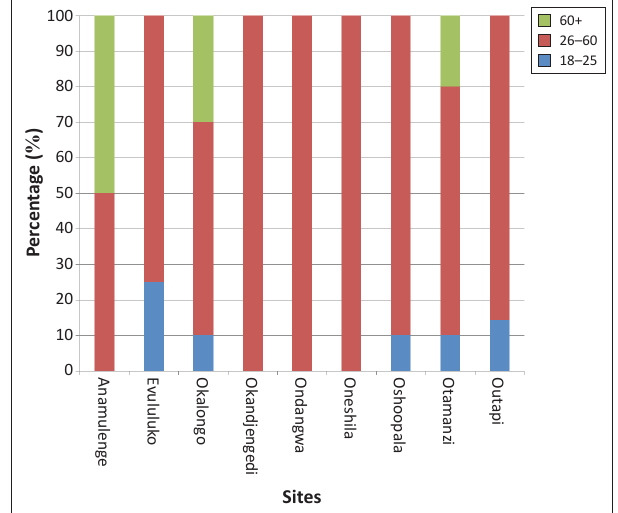
FIGURE 4: Age group as per survey